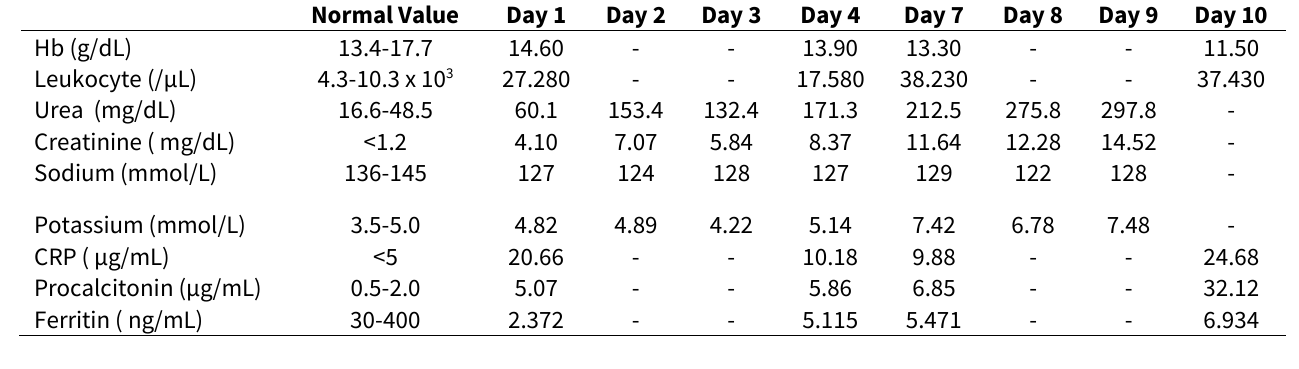
Table 2. Results of Monitoring Laboratory Examination of the 2nd Patient